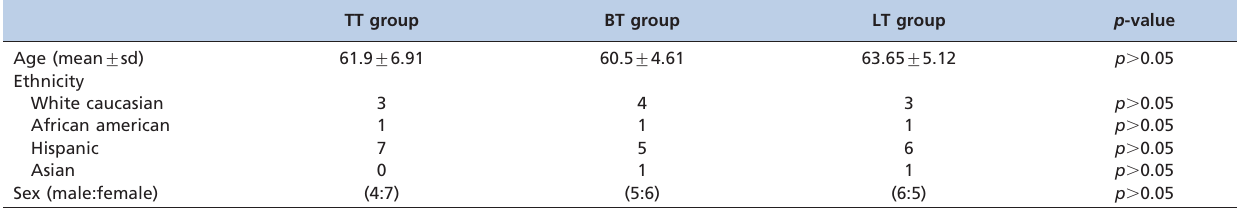
Table 1 - Demographic data: age, sex and